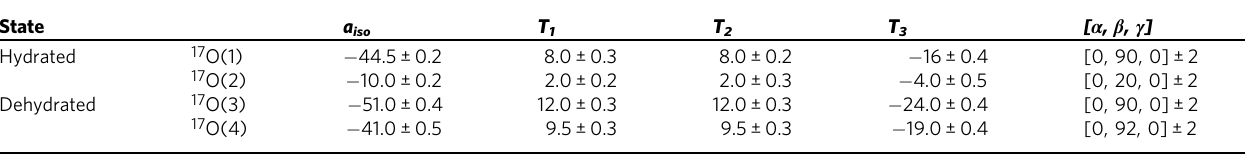
Table 3 Experimental 17 O hyper fi ne coupling components and quadrupolar coupling constants used for the simulations of Davies ENDOR spectra in Fig. 4.